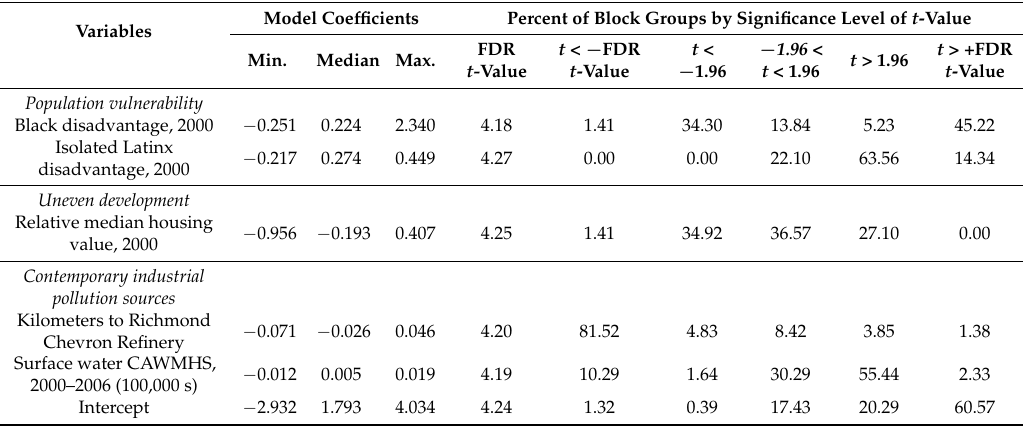
Table 9. Summary statistics for the GWLR results for block group 50 percent areal containment within a 2006, 303(d), impaired water hazard zone on population vulnerability, uneven development, and contemporary industrial pollution source factors (N = 3401 block